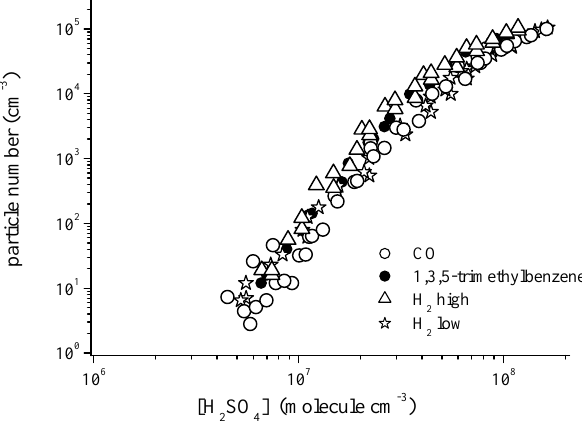
Fig. 4. Apparent nucleation rate as a function of H 2 SO 4 concentra- tion for different residence times in the irradiated middle section of the IfT -LFT; RH=22%; butanol-based UCPC (TSI 3025).